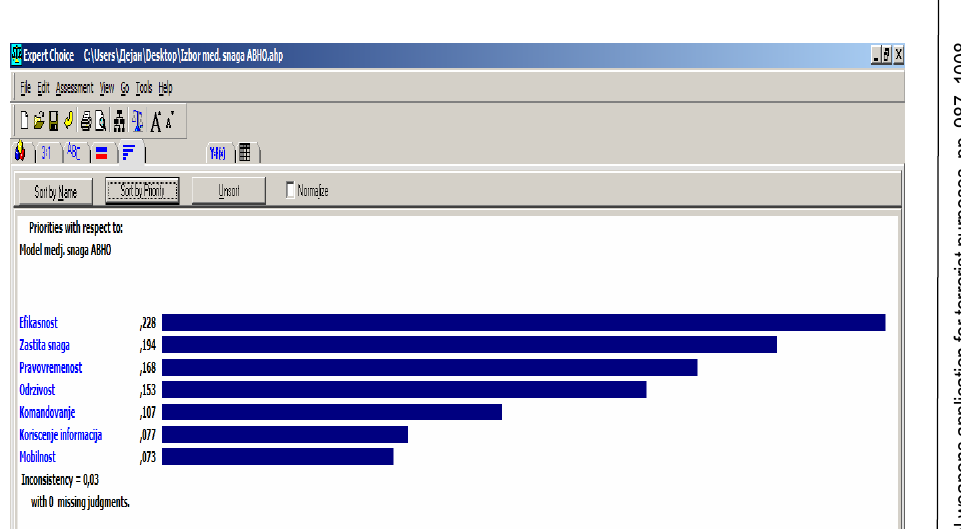
Figure 2 – Priorities when selecting the criteria for international CBRN forces Рис . 2 – Приоритеты при выборе критериев международных войск РХБЗ